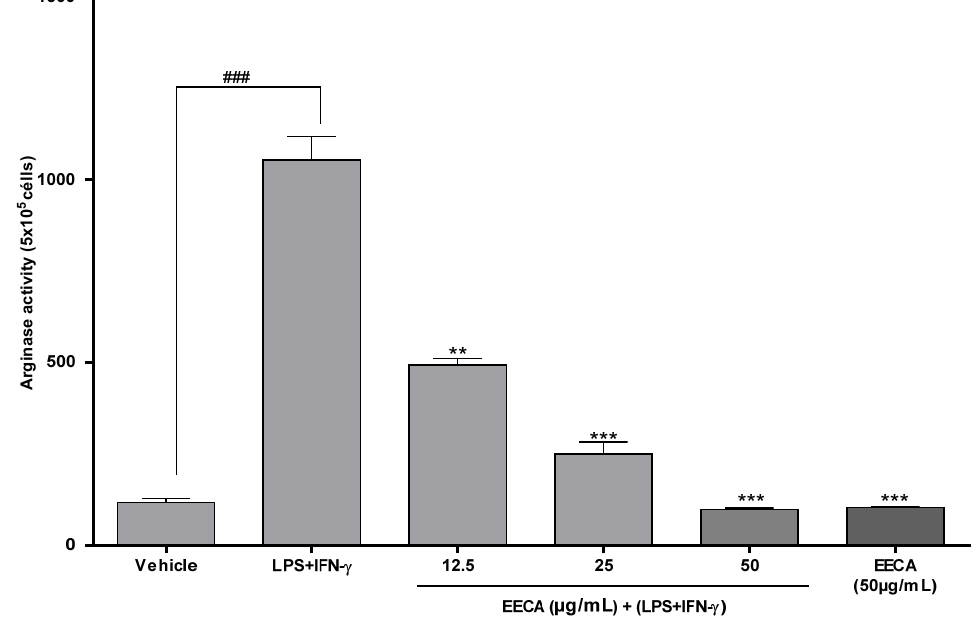
Figure 2. The effect of EECA on the activity of the arginase enzyme in IFN- γ stimulated peritoneal macrophages and LPS + IFN- γ . Data were obtained from at least three independent experiments and are expressed as mean ± SD. ** p < 0.01 and *** p < 0.001 indicate a difference between the LPS + IFN- γ (1 µ g/mL)-stimulated group and the EECA-treated group. ### p < 0.001 indicates a significant difference between the control group (mean + 2% of DMSO) and the group stimulated by LPS + IFN- γ (1 µ g/mL). EECA: ethanolic extract of the rhizome of C. articulatus